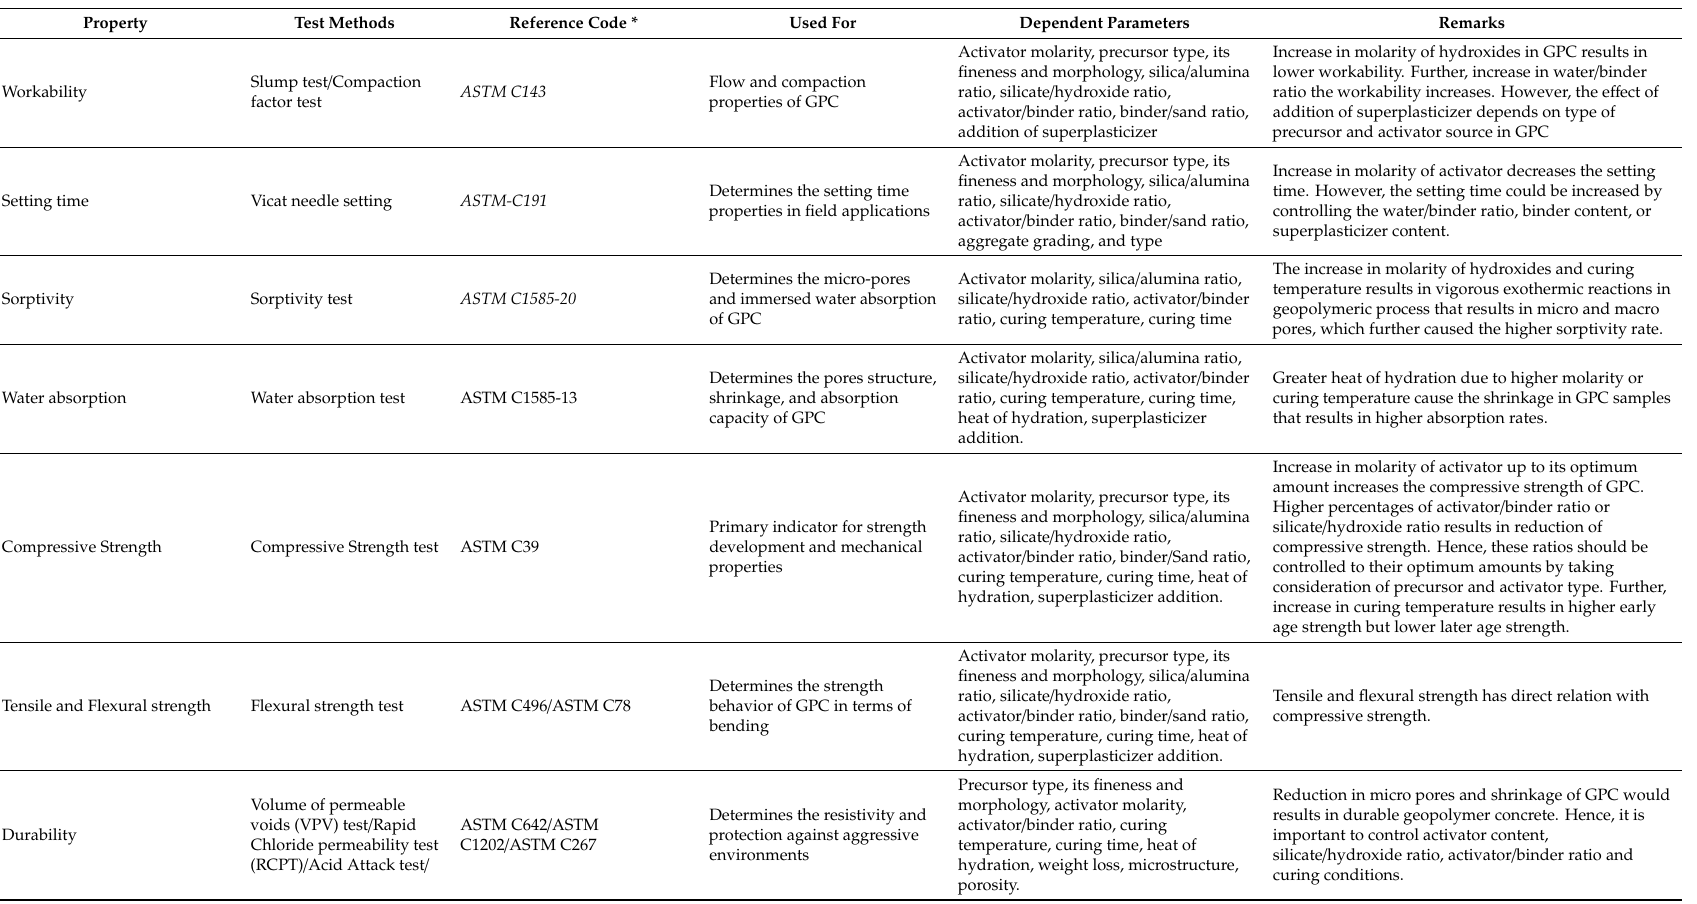
Table 7. Overview on fresh and hardened properties on